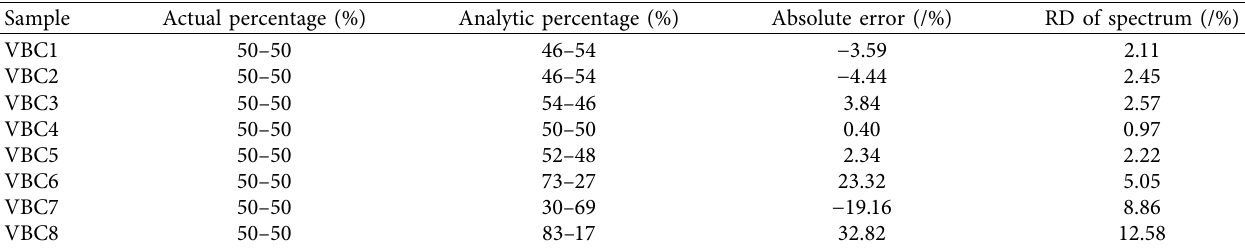
Table 9: The analytic percentage, the actual percentage, the absolute error of both, the relative deviation between the actual mixed homogeneous spectrum, and the simulated mixed spectrum of the vitamin sample.